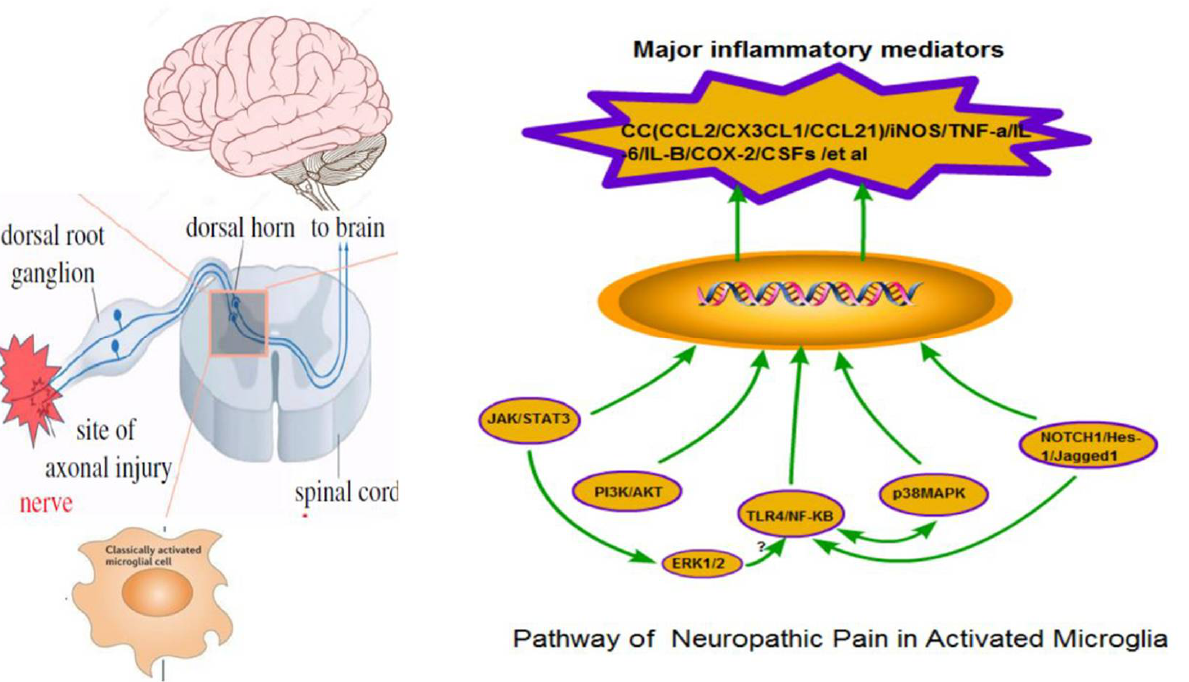
Figure 1. Neuropathic pain and microglia signal transduction pathway. DRG: dorsal root ganglia; CC: chemokines; IL: interleukin; CSFs: colony stimulating factors; TNF: tumor necrosis factor; iNOS: inducible nitric oxide synthase; COX-2: cyclooxygenase 2; p38MAPK: p38 mitogen-activated protein kinase; ERK: extracellular signal-regulated kinase; TLR4: toll-like receptor 4; NF- κ B: nuclear factor-kappa B; PI3K: phosphatidylinositide 3-kinase; AKT: proteinkinaseB; JAK: c-Jun N-terminal kinase;